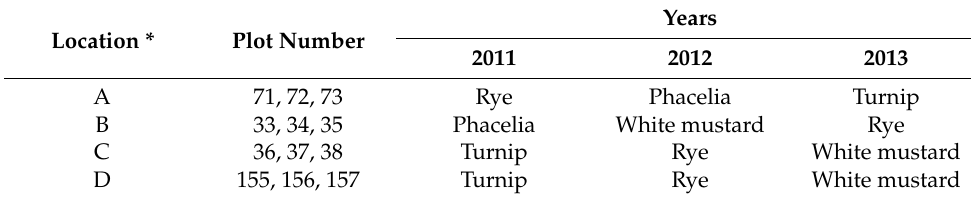
Table 4. Crop rotation on the farm in